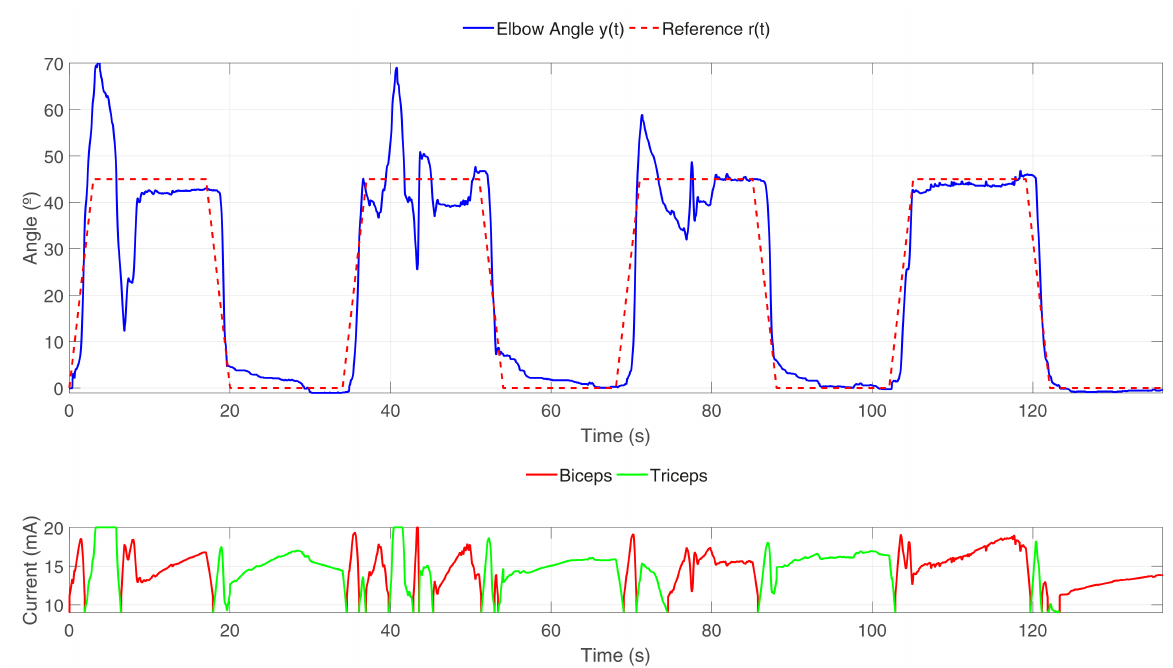
Figure 8 - Adaptive PID (volunteer 2): response y and reference r ; control signal u .